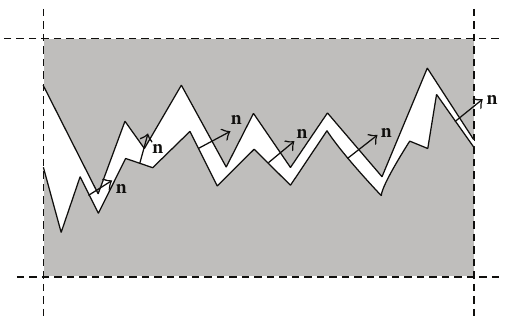
Figure 5: Normal contact definition in the fractal